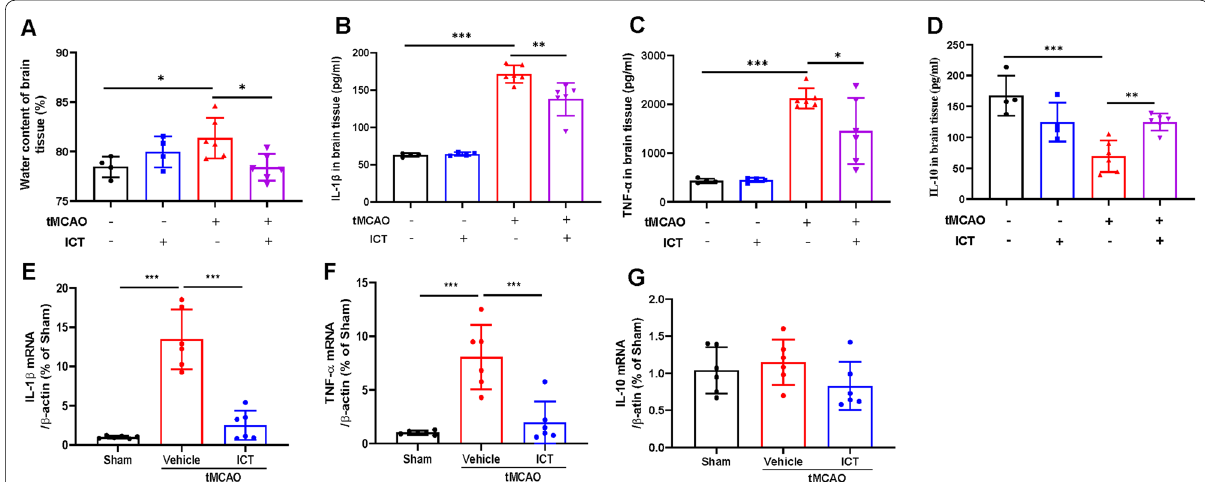
Fig. 2 ICT attenuates brain edema and neuroinflammation in rats after CI/RI. A The water content of rat ischemic lateral brain tissue (n B – D IL-1β, TNF-αand IL-10 in brain tissue of rat ischemic penumbra (n penumbra (n 6). The results are expressed as the mean =